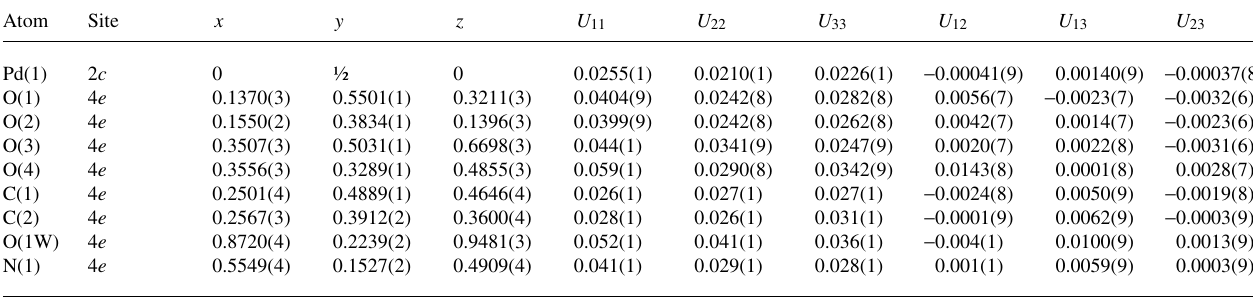
Table 3. Atomic coordinates and displacement parameters (in Å 2 ) .